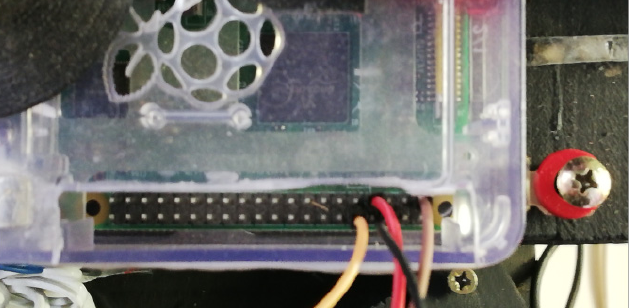
Figure 6. 40-pin GPIO connectors to synchronize the triggering of the three